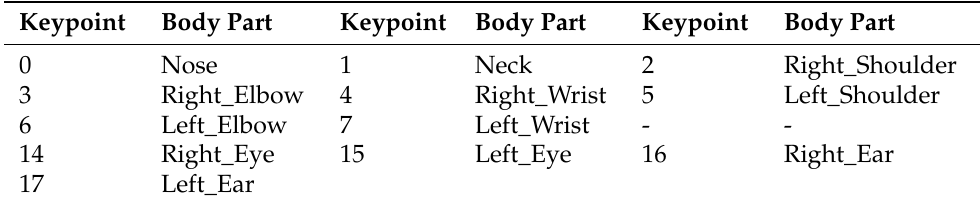
Table 1. Keypoint Sampling: The proposed experiments use input video samples, where PoI’s upper body language is used to train the machine learning algorithm. Therefore, we selected a COCO-style keypoint dataset sampling method. This pose sampling method extracts 18 human body keypoint. Though for our proposed method, we only extracted 12 samples because the rest of the PoI body was hidden behind the